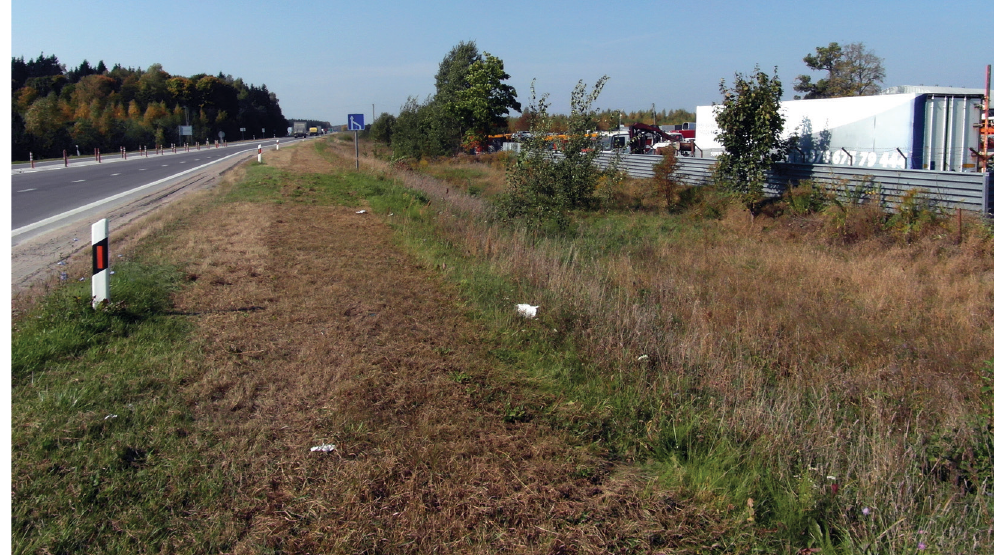
Figure 8. The view on the land strip between the route E28 and the target (the site of a used car store) (the authors’